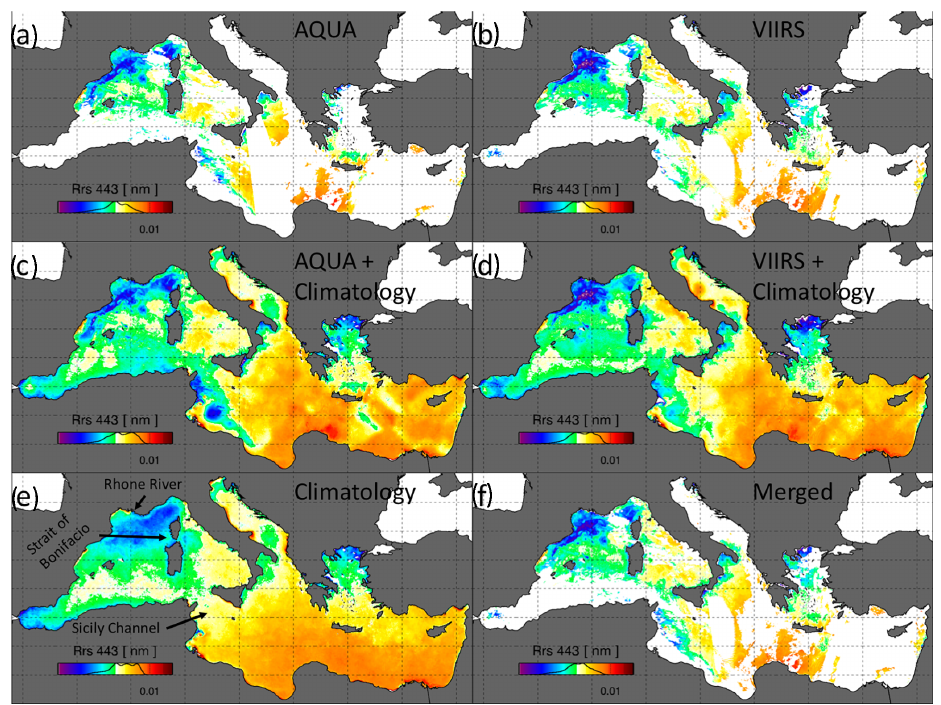
Figure 4. Example of how the merging of MODIS and VIIRS works. Rrs 443 from MODIS Aqua (a) and NPP-VIIRS (b) from 1 April 2012. Panels (c) and (d) are obtained by filling in panels (a) and (b) with daily climatology (e) . The merged multi-sensor product is obtained after removal of the unseen pixels (f) . Distribution histograms for each image are included in relevant colour bars.